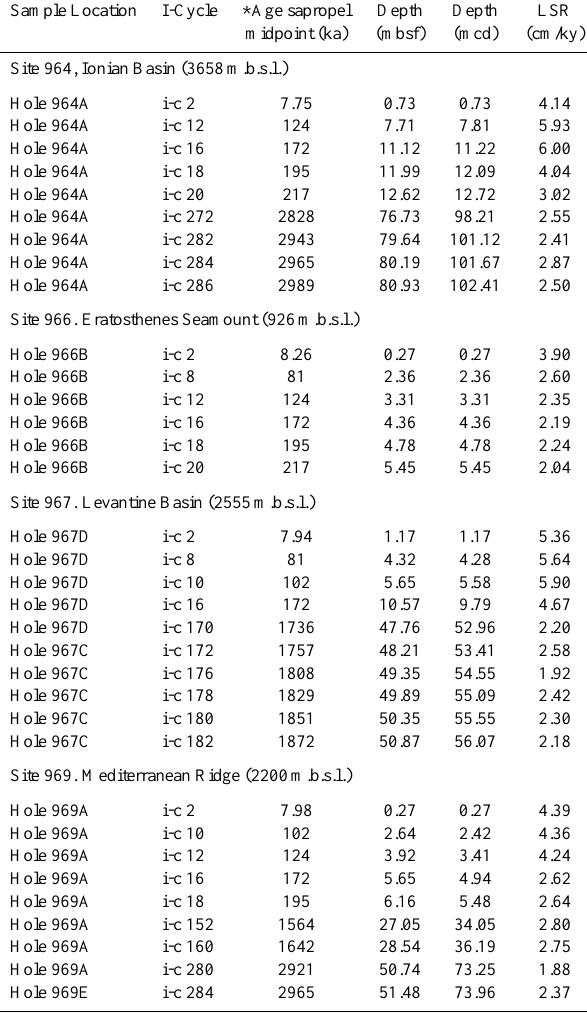
Table 1. Summary of analyzed sapropel layers with their corre- spondent depth, assigned insolation cycle, age (mid-point) and cal- culated Linear Sedimentation Rate (LSR) for each